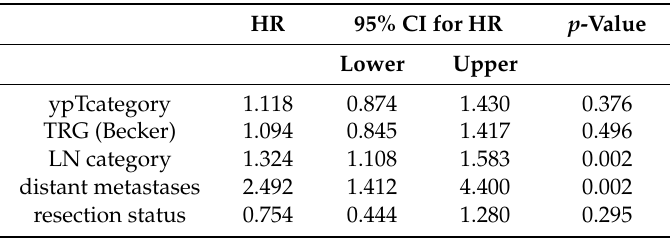
Table 3. Multivariate Analysis.